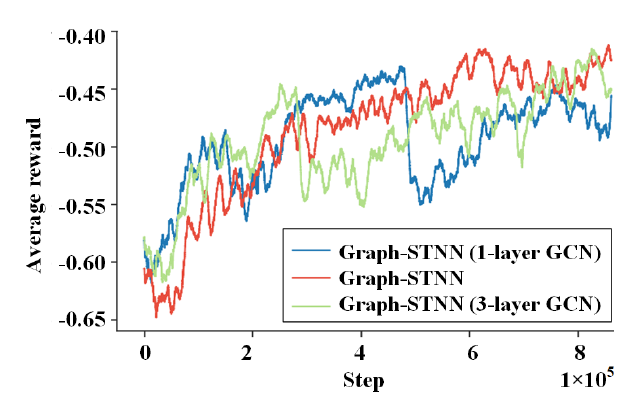
Figure 7. The training performance of Graph-STNN with different-layer GCN in the spatial encoder in our setting with the size of 20 m × 20